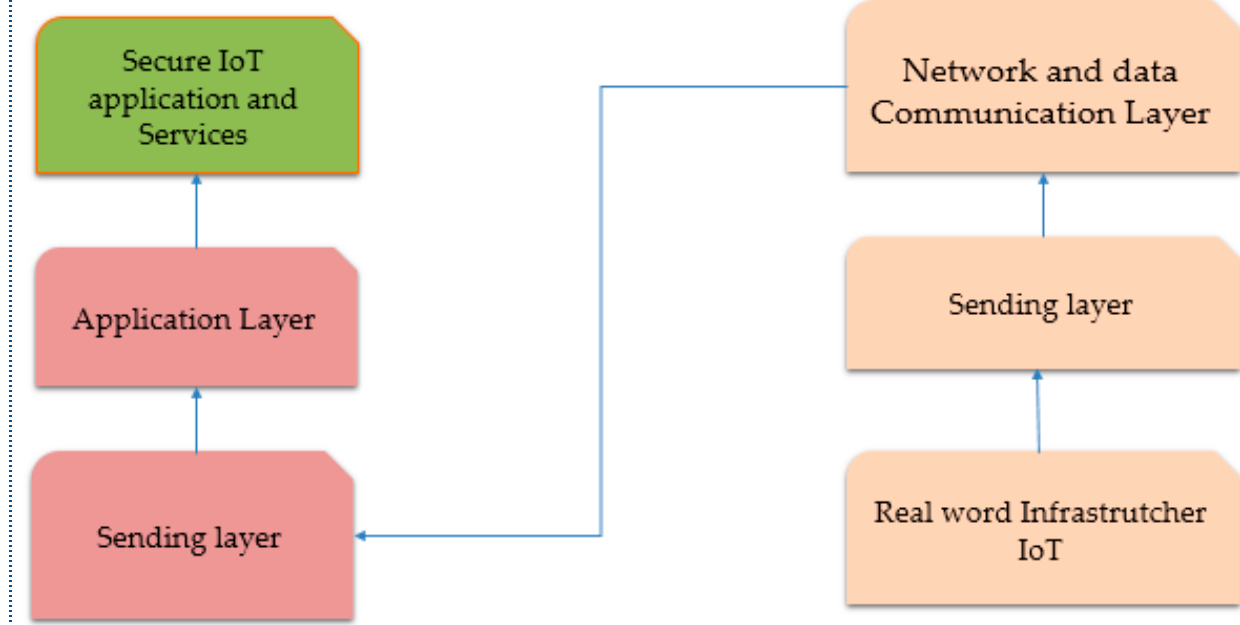
Figure 8. Layered Architecture [66].